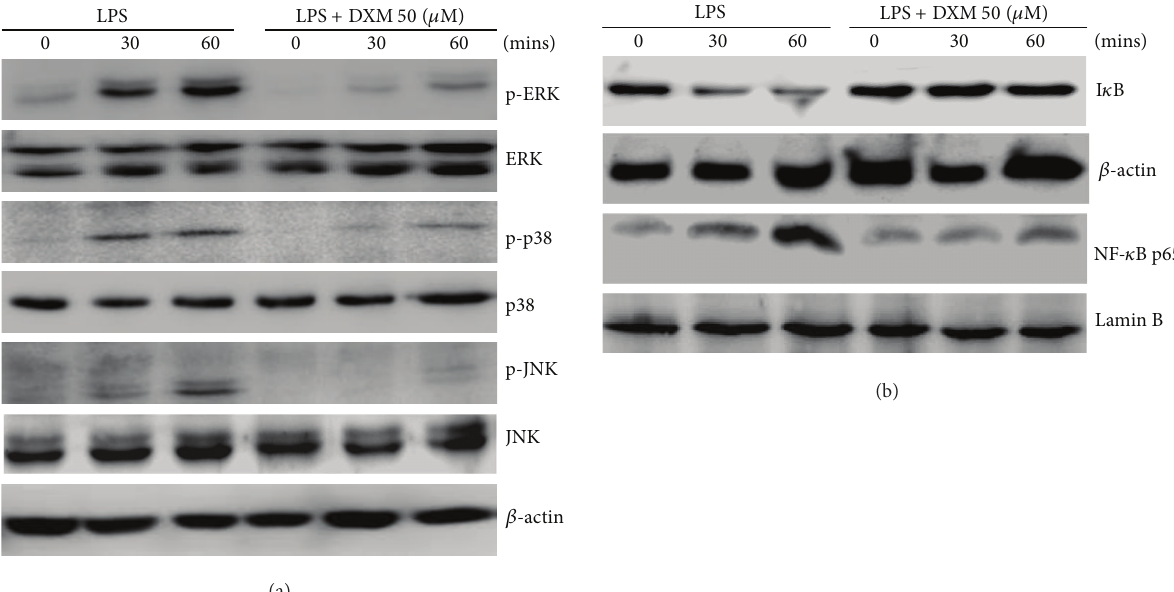
Figure 5: DXM inhibition of MAPK and NF- 𝜅 B activation in BMDCs. Immature BMDCs were stimulated with 100ng/mL LPS with or without DXM and lysed at the indicated time points. (a) The ERK, JNK, and p38 MAPK (native and phosphorylated) in whole cell lystes. (b) I 𝜅 B 𝛼 in whole-cell lystes and NF- 𝜅 B p65 in nuclear extracts as mentioned were determined by Western blot with antibodies. 𝛽 -actin and Lamin B loading controls are also shown to demonstrate relatively equal protein load across all lanes. The data are representative of three independent experiments showing similar